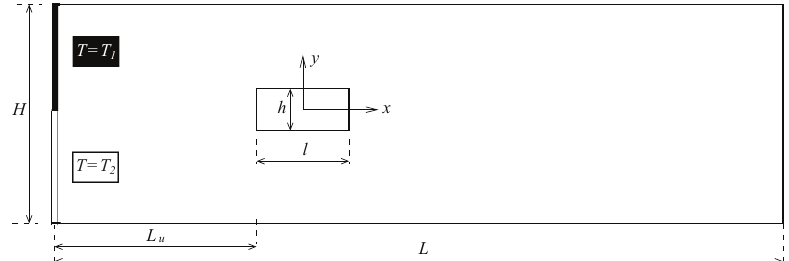
Figure 1. Sketch of the microchannel geometry with a rectangular structure positioning in the